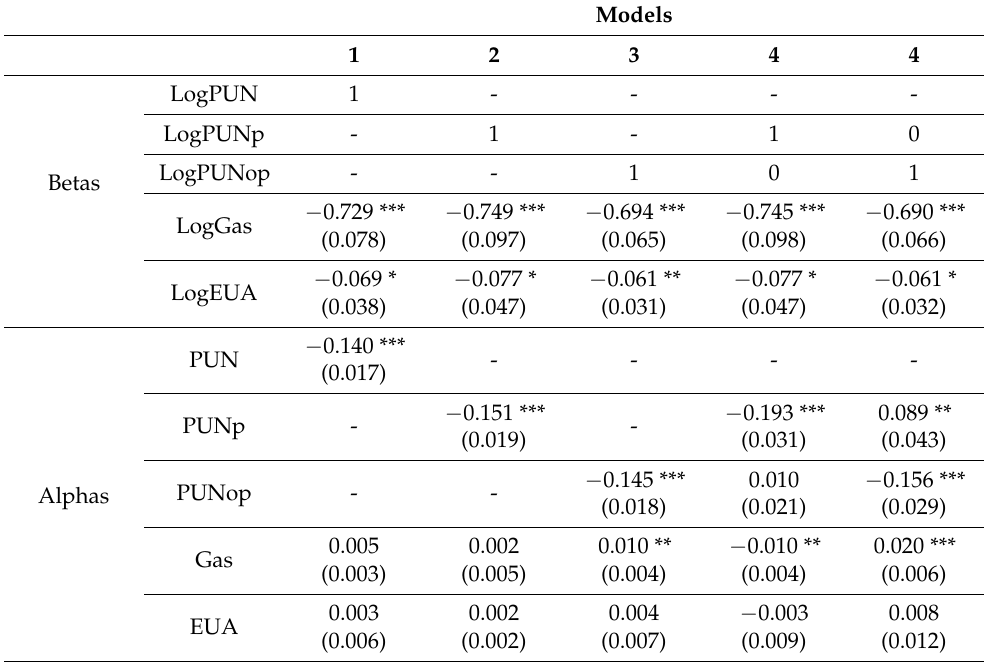
Table 3. The cointegrating equation.